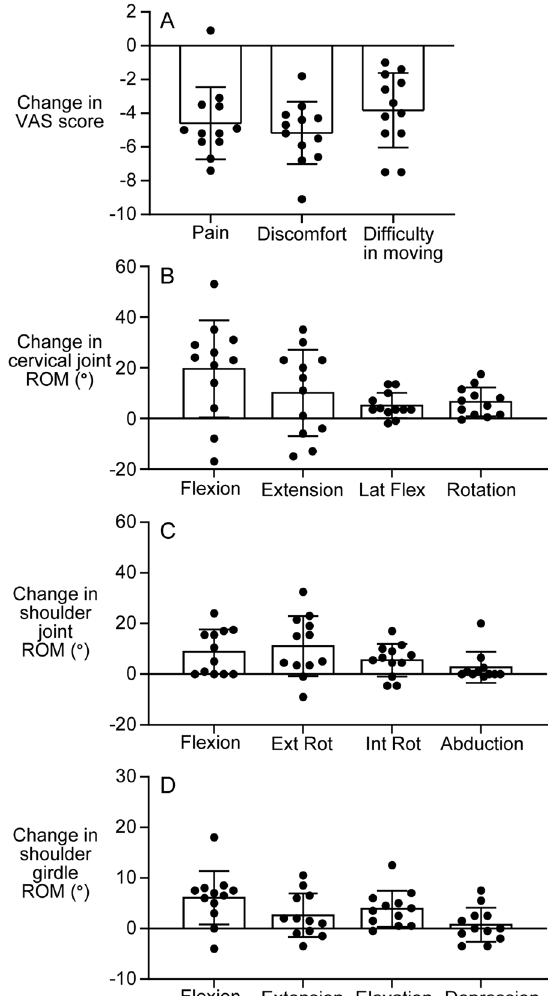
Fig. 4 The magnitude of changes in subjective symptoms ( A ) and range of motion ( B – D ). Data obtained before self-care periods were subtracted from those after self-care. The individual closed circle indicates data obtained from each participant. The bar chart and vertical bar indicate the mean and standard deviation. N 12. Ext = Rot external rotation, Int Rot internal rotation, Lat Flex lateral = = = flexion, ROM range of motion, VAS visual analog = =